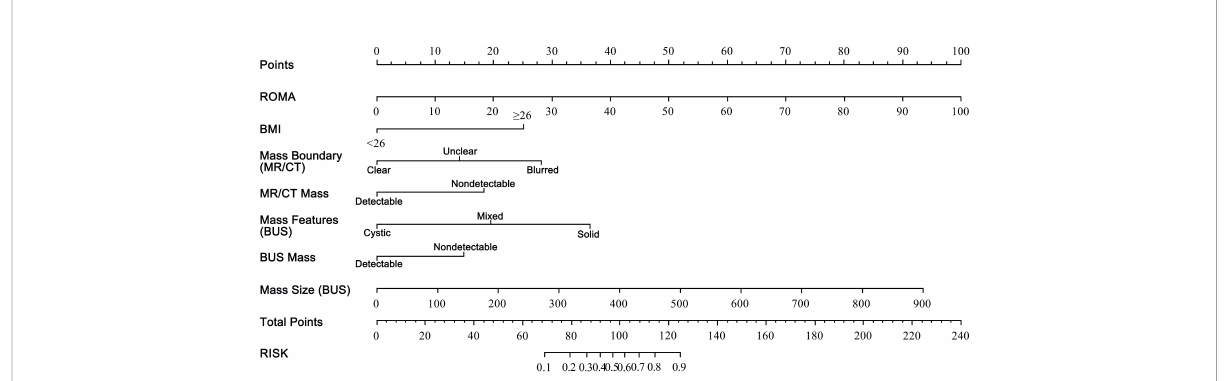
FIGURE 1 The nomogram for predicting malignant risk of ovarian tumors.The nomogram was developed in the primary cohort, with the variables of ROMA score, BMI ≥ 26, blurred and unclear boundary (MR/CT), mass detection (MR/CT), solid and mixed mass (BUS), mass detection (BUS), and